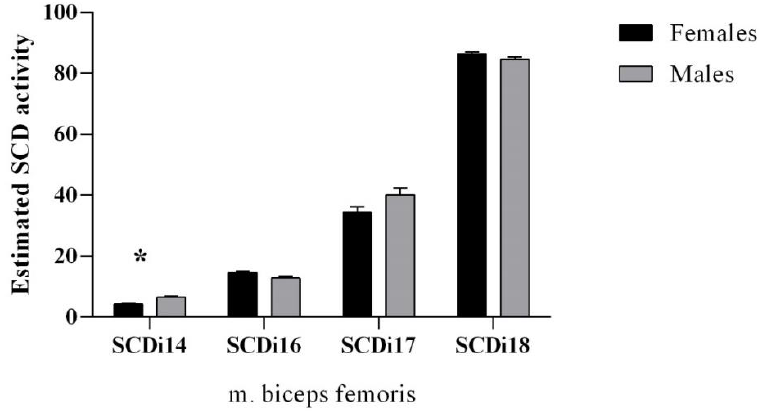
Figure 2. Stearoyl-CoA desaturase activity indices of edible dormouse ( Glis glis ) muscle ( m. biceps femoris ). * statistical significance at p <